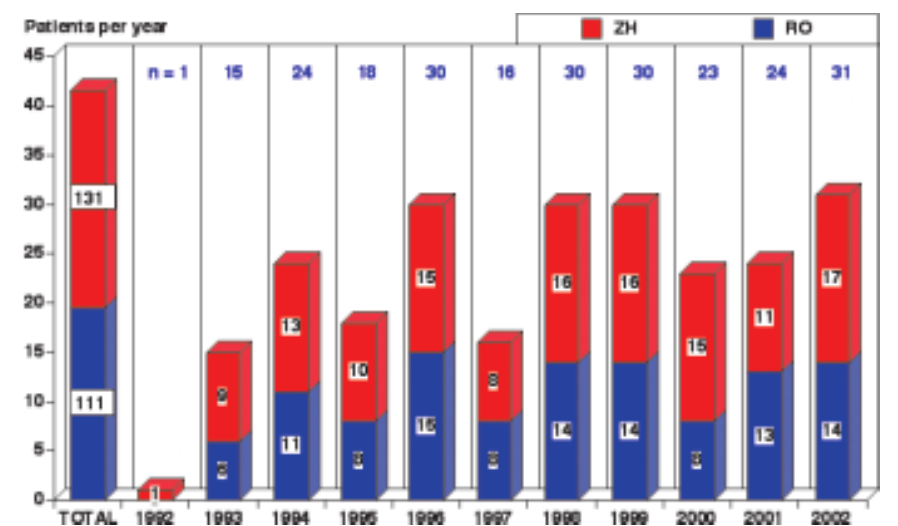
Annual transplanta- tion rates in the two centres (ZH = Zurich University Hospital; RO = Centre de Romandie).